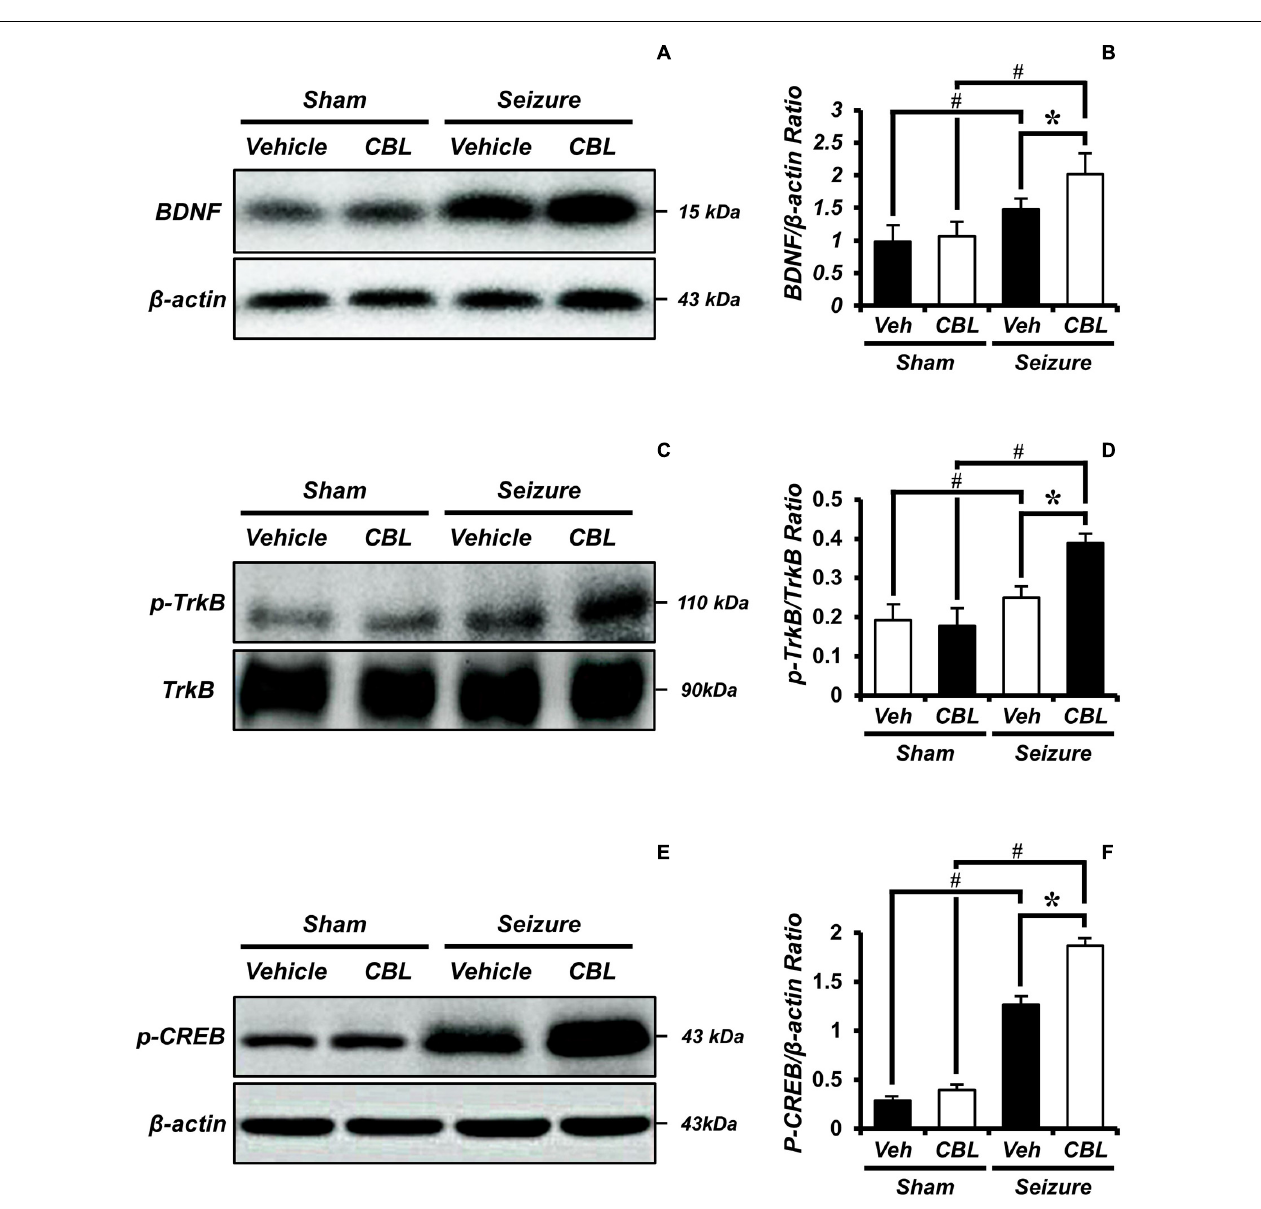
FIGURE 6 | Cerebrolysin increases the levels of brain-derived neurotrophic factor (BDNF), phospho-tyrosine kinase receptor B (p-TrkB), and phospho-cAMP-response-element-binding (p-CREB) after pilocarpine-induced seizure. The administration of cerebrolysin increased BDNF after pilocarpine-induced seizure. (A) The level of BDNF in the hippocampus. After a seizure, the administration of cerebrolysin increased BDNF expression in the hippocampus compared to the seizure-vehicle groups. (B) A graph of the BDNF. (C) The level of p-TrkB in the hippocampus. After a seizure, the administration of cerebrolysin increased p-TrkB expression in the hippocampus compared to the seizure-vehicle groups. (D) A graph of the p-TrkB. (E) The level of p-CREB in the hippocampus. After a seizure, the administration of cerebrolysin increased p-CREB expression in the hippocampus compared to the vehicle groups. (F) A graph of the p-CREB. The data are the mean ± SEM, n = 3–4, for each seizure group. * p < 0.05 vs. vehicle-treated group; # p < 0.05 vs. sham-operated group [Kruskal–Wallis test with post hoc test: (B) Chi square = 9.705, df = 3, p = 0.021, (D) Chi square = 9.029, df = 3, p = 0.029, (F) Chi square = 11.895, df = 3, p =